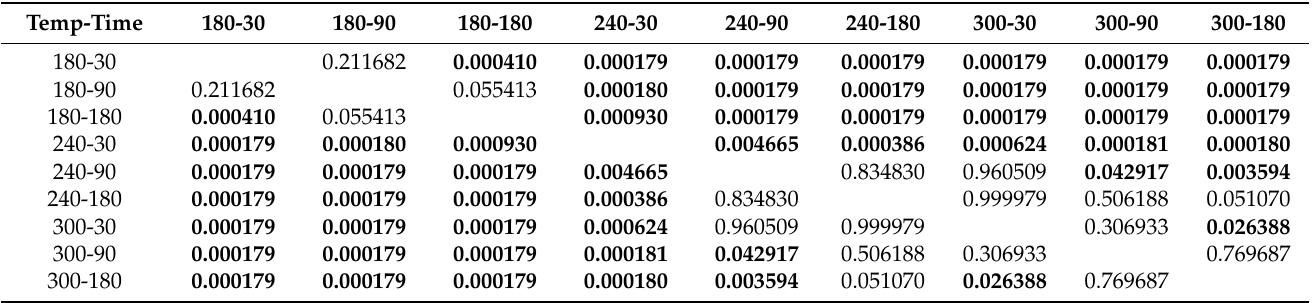
Table A15. Two-way analysis of variance (ANOVA) with post hoc Tukey test for O , a bold font signifies a statistically significant difference ( p < 0.05).